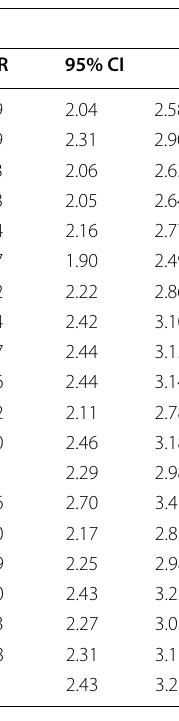
Table 1 Standardized mortality ratios in the study period for patients diagnosed with schizophrenia and patients diagnosed bipolar disorder,